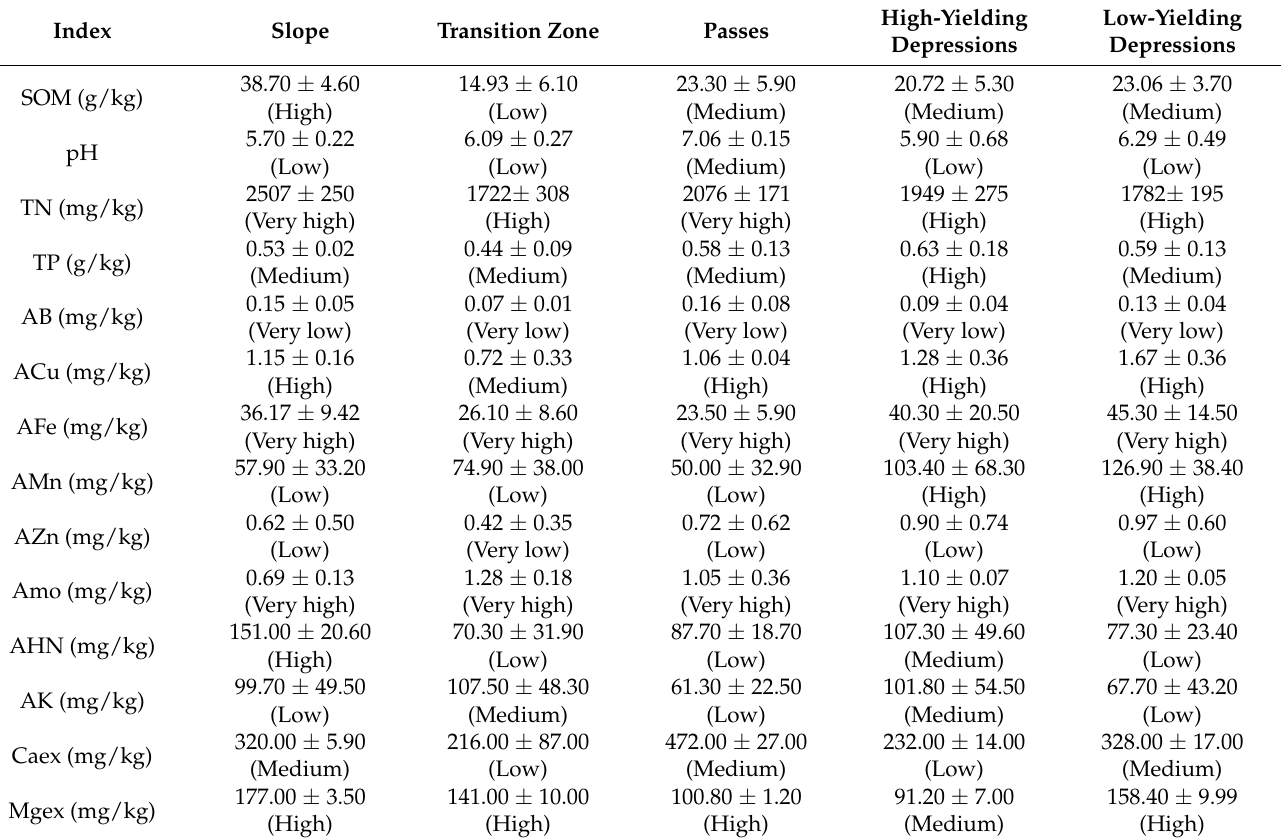
Table 4. Difference of soil nutrient index concentrations in different geomorphic